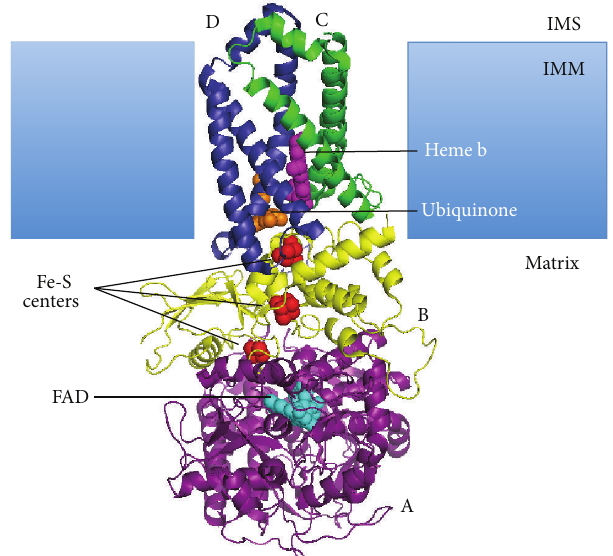
Figure 3: Structure of succinate dehydrogenase [20]. The enzyme is conserved through evolution and has two transmembrane subunits (SDHC and SDHD) and two matrix subunits (SDHA and SDHB). SDHA contains a bound FAD cofactor and the binding site for succinate. SDHB has three Fe-S centers. Heme b and ubiquinone are sandwiched between SDHC and SDHD. Electron pairs move from the substrate succinate to FAD, through the three Fe-S centers, and then to ubiquinone. Heme b prevents reactive oxygen species formation and does not participate in electron transfer. IMS (intermembrane space); IMM (inner mitochondrial